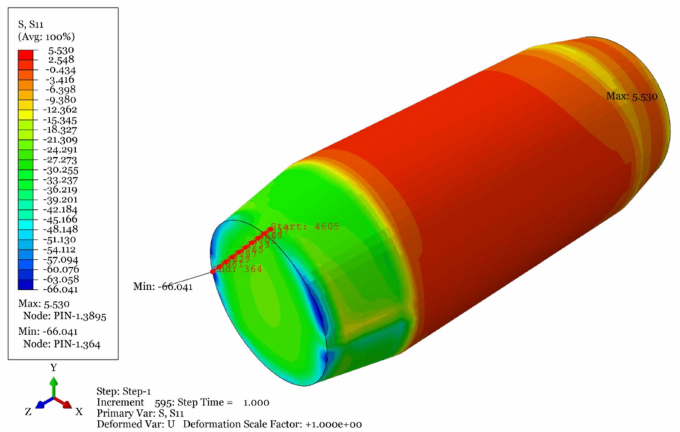
Figure 10. S11 stress distribution in pin resulted from 200 Nm torque.